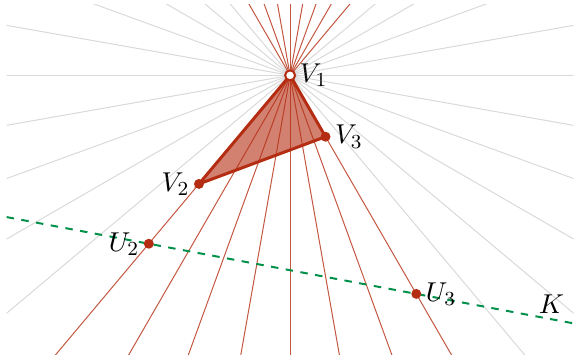
Figure 4 . Fibration of CP 2 and a 2 -simplex, with respect to the 0 -face V 1 . We represent the reference point V by a circle, meaning that this point needs to be removed when doing the fibration, 1 but later added back for the discussion of integrals. The red lines are the fibres that have non-trivial overlaps with the 2 -simplex. In this fibration the original integral divides into integral along each red line (where the contour is the intersection of the 2 -simplex and the line) and integral over the set of red lines. This fibration is special in that the 1 -faces adjacent to V also analogously fibrated (although the induced fibration is trivial in this case of CP 2